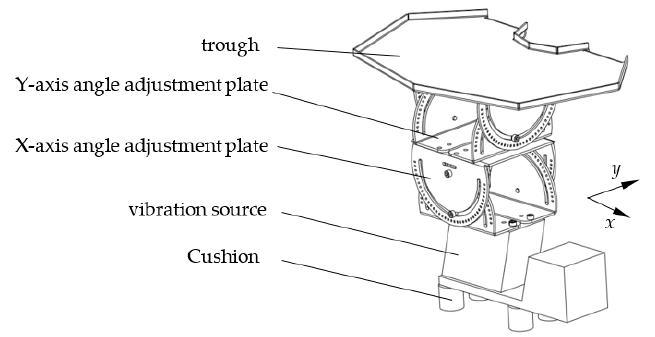
Figure 1. Head-to-tail orientation